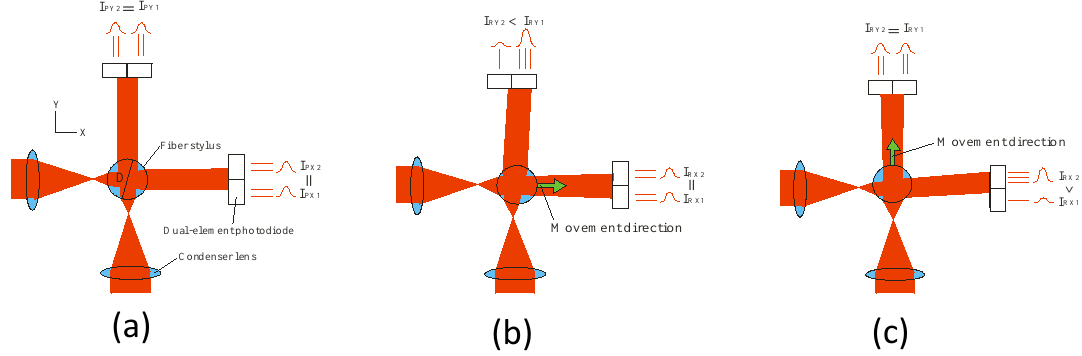
Figure 3. Principle of measurement. ( a ) initial stage; ( b ) displacement in X -direction; and ( c ) displacement in Y -direction.